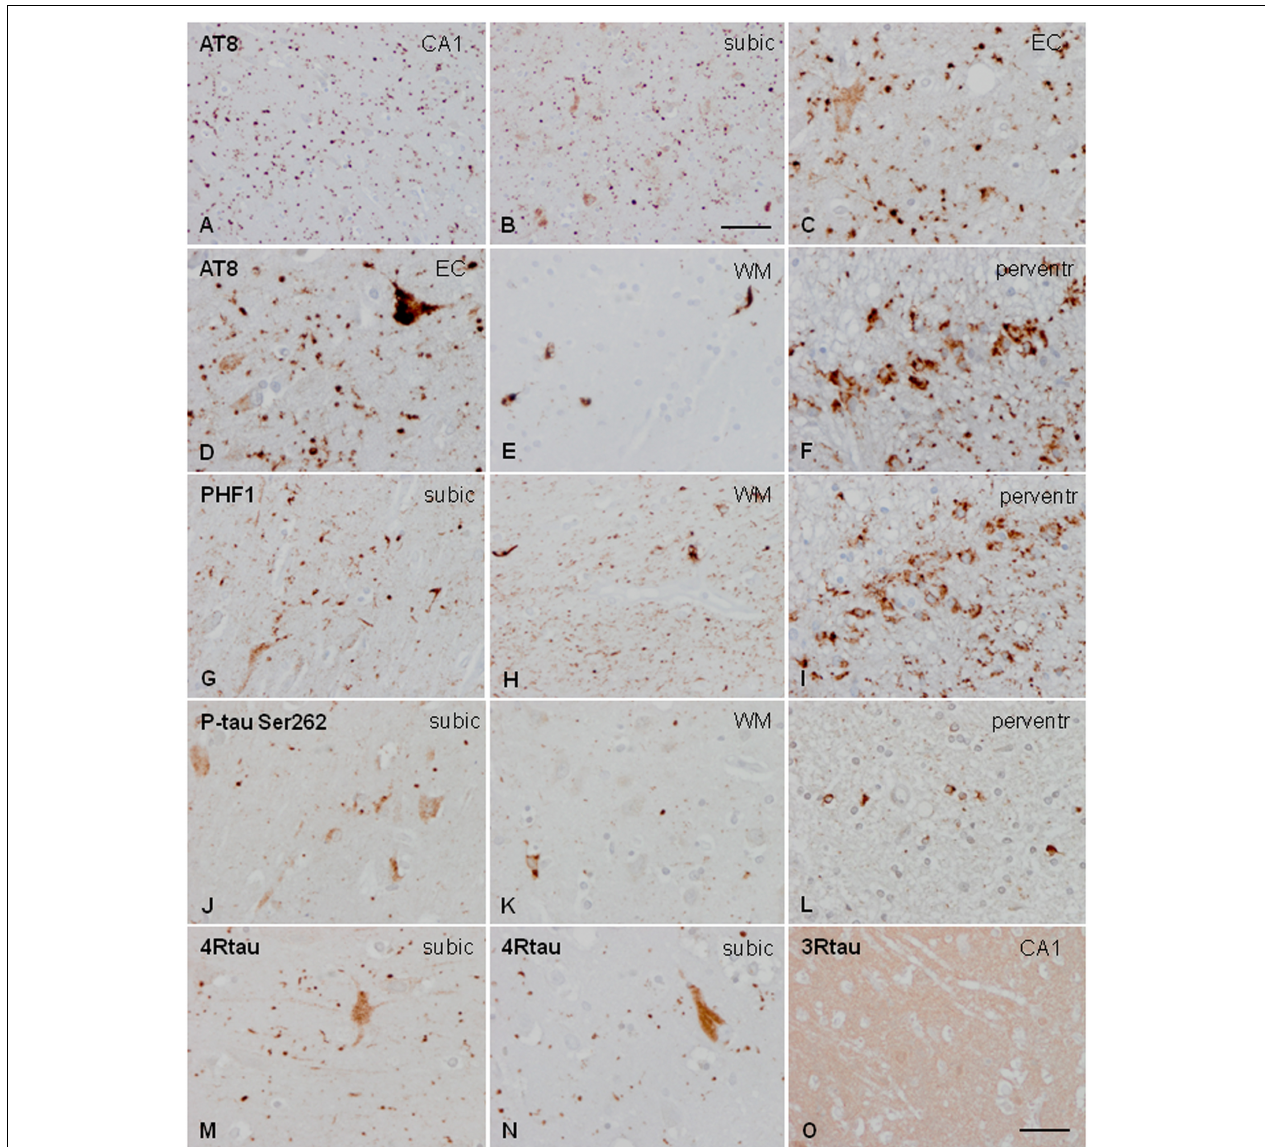
FIGURE 1 | Characteristics of tau deposits in AGD. Hyper-phosphorylated tau deposits are seen in the CA1 region of the hippocampus (CA1: A ), subiculum (subic: B,F,J,M,N ), entorhinal cortex (EC: C ), white matter of the hippocampus (WM: E,H,K ), and periventricular region of the temporal horn (perventr: F,I,L ). Grains are identified as small round, lobulated, or comma-shaped deposits in the neuropil (A–C,D,G,J) . Grains are accompanied by pre-tangles in neurons (C,D,G,J) , and, rarely, by neurons with dense granular inclusions (D) . In addition, oligodendroglial deposits form coiled bodies and cytoplasmic inclusions around the nucleus (E,H,K) . Thorn-shaped astrocytes (TSAs) are common in the periventricular white matter (F,I,L) . All these deposits are stained with AT8 antibodies (A–F) , PHF1 (G–I) , and anti-P-tau Ser262 (J–L) . Grains and pre-tangles are composed of 4Rtau (M,N) and do not contain 3Rtau (O) . Paraffin sections, processed